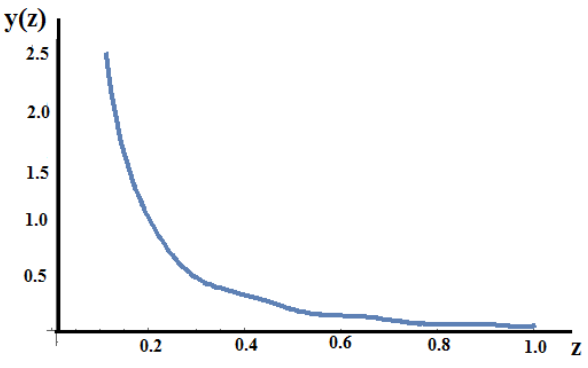
Figure 19. The non-dimensional displacement field y ( z ) in the initial space. However, recalling that z = 1 − x , Figure 19 is transferred into the x initial plane with Figure 20.